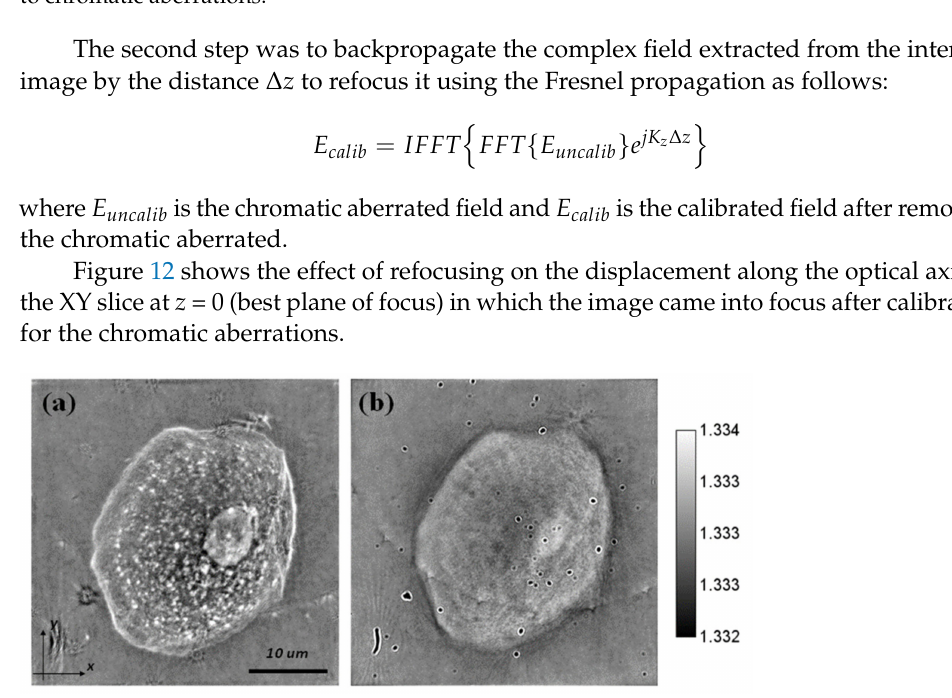
Figure 11. Effect of chromatic aberrations on the 3D RI reconstruction at green illumination ( left ) and blue illumination ( right ). Note how the 3D reconstruction at blue is shifted from the z = 0 plane due to chromatic aberrations.